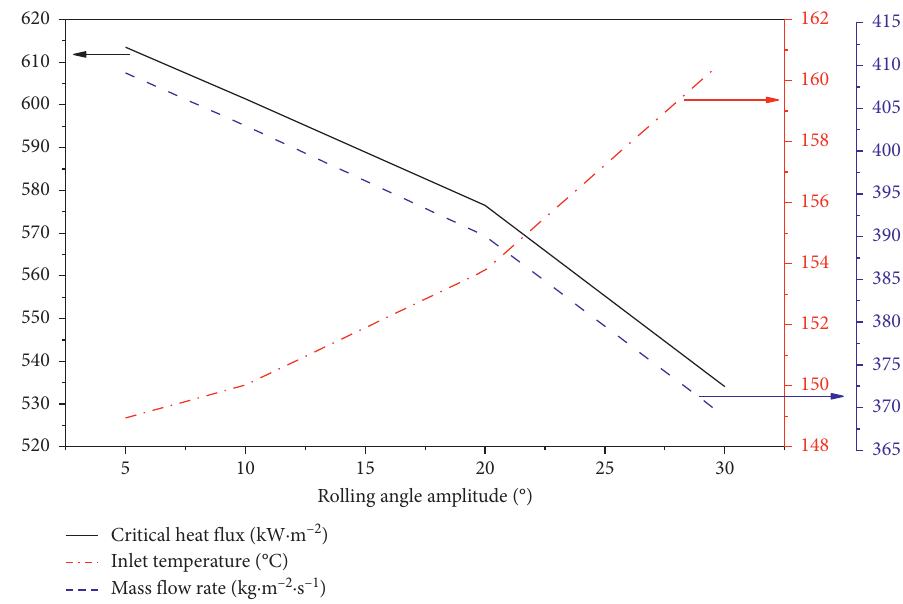
Figure 18: Influence of rolling angle amplitude on CHF, T �